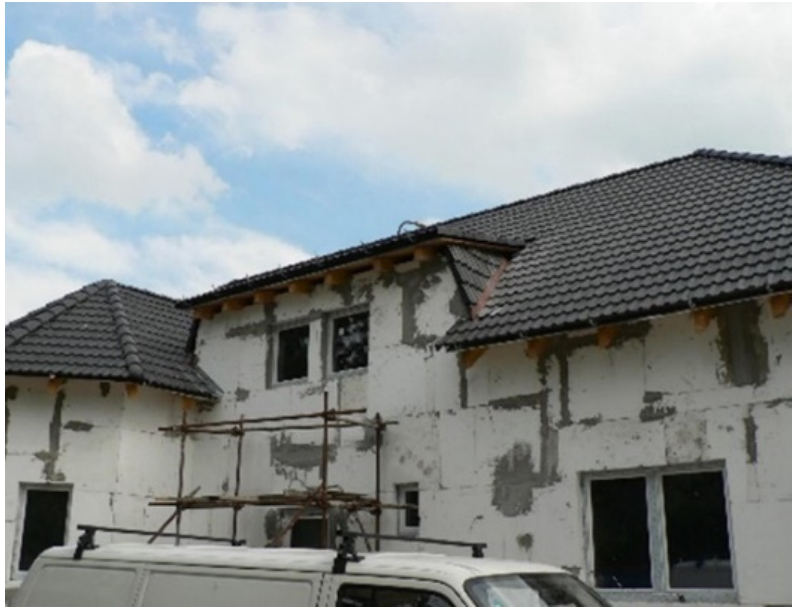
Figure 30. View of the implementation of the insulation of the perimeter panels (photo archive: Kal ú s, D.)